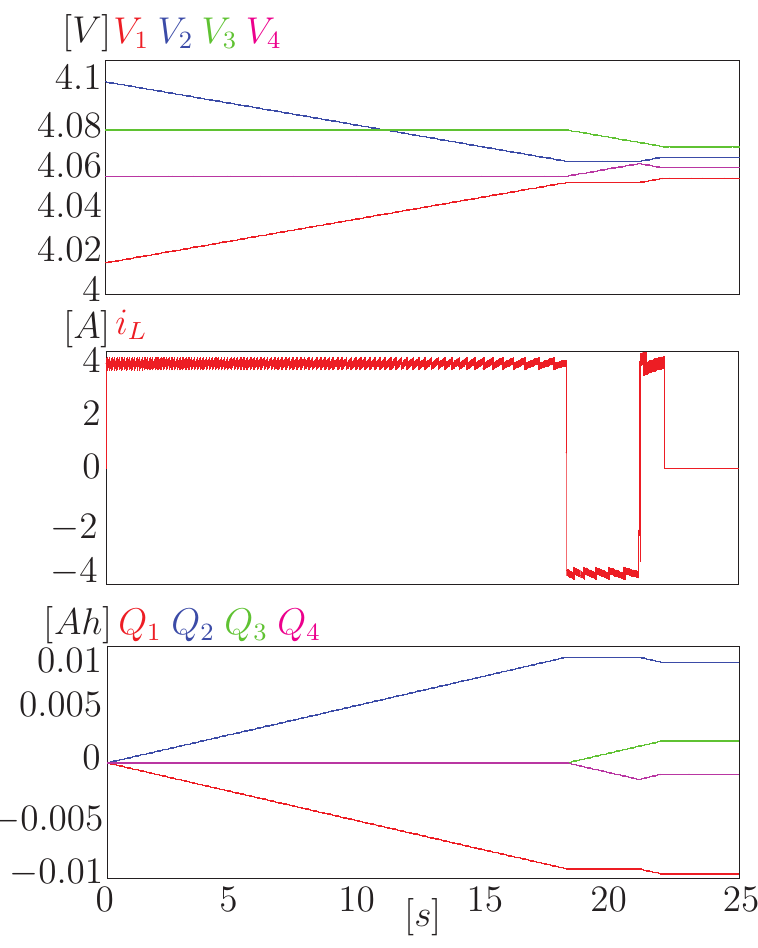
Figure 11. Equalization of a four-cell battery bank using the proposed